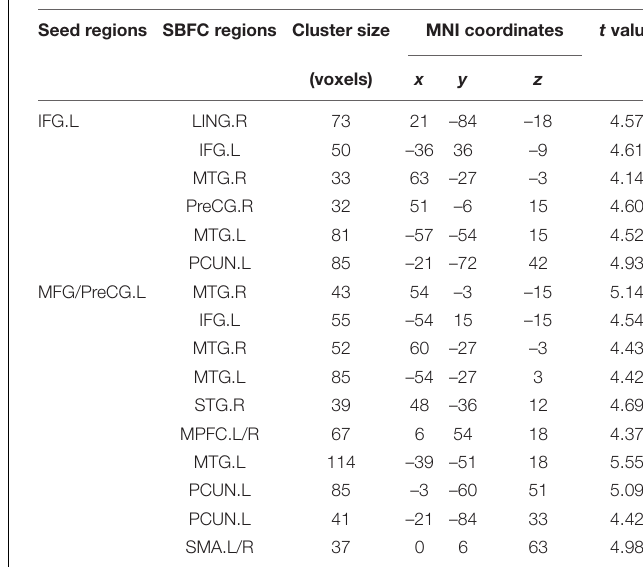
FIGURE 2 | Altered network connectivity in the individual differences of insightful problem solving, using two seed clusters in the DC correlation analysis. Brain connectivity mainly involves ECN and DMN. The color bar refers to t -value. IFG.L, left inferior frontal gyrus; MFG.L, left middle frontal gyrus; PreCG.L, left precentral gyrus; ECN, executive control network; DMN, default mode network.